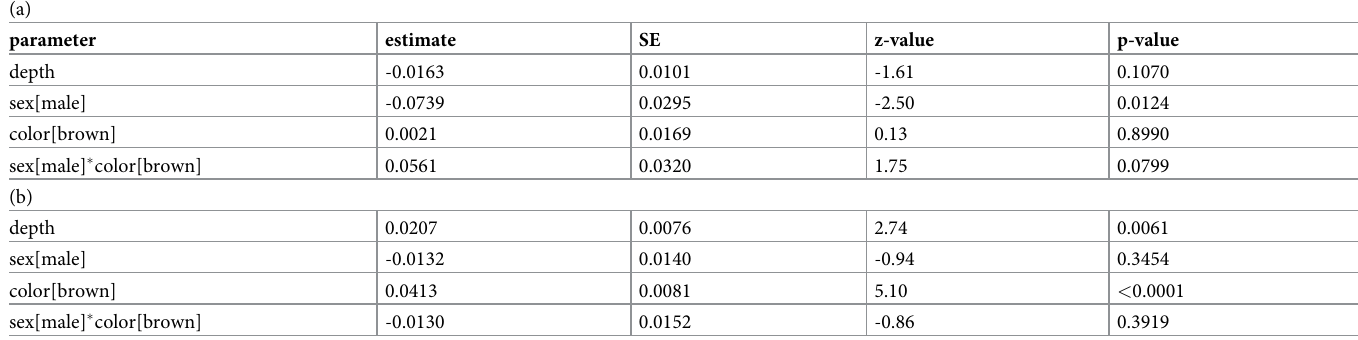
Table 2. Results of general linear mixed models for (a) Fulton’s K and (b) hepatosomatic index. (a) Fulton’s K (n unique fish hosts = 2087, n sampling locations nested within sampling regions = 87, and n sampling regions = 7). (b) hepatosomatic index (n unique fish hosts = 2076, n sampling locations nested within sampling regions = 87, and n sampling regions =